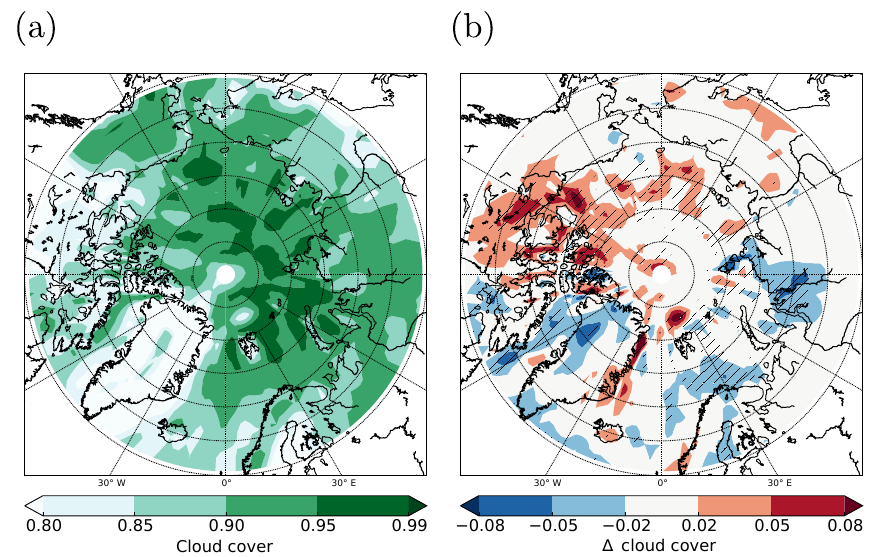
Figure 6. (a) Cloud cover in 2004 and (b) differences between 2050 and 2004 (i.e. between simulations arctic_2050_EM2004 and arc- tic_2004) in early autumn (September–October). Hatched areas are significant at the 95% confidence